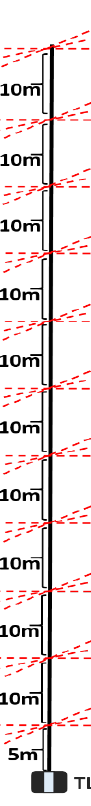
Figure 4. Scan plan. Red dashed line represents orientation of the designed stand with respect to TLS. Assuming that coated glasses are exactly planar and distance of each point to the plane is same, the best fitting plane for each coated glass was computed using the least squares solution. In order to compute the best fitting plane, Equation 9 was used.